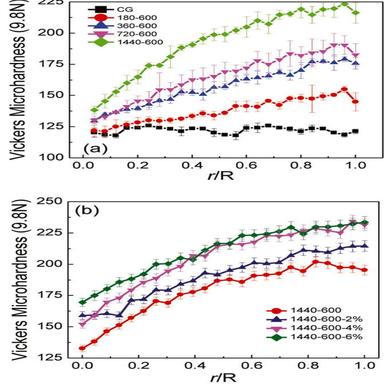
(a) Dependence of Vickers microhardness on the radius of LA steel subjected to PTA treatments and its CG counterpart, (b) Evolution of Vickers microhardness of the 1440-600 sample with tensile deformation.